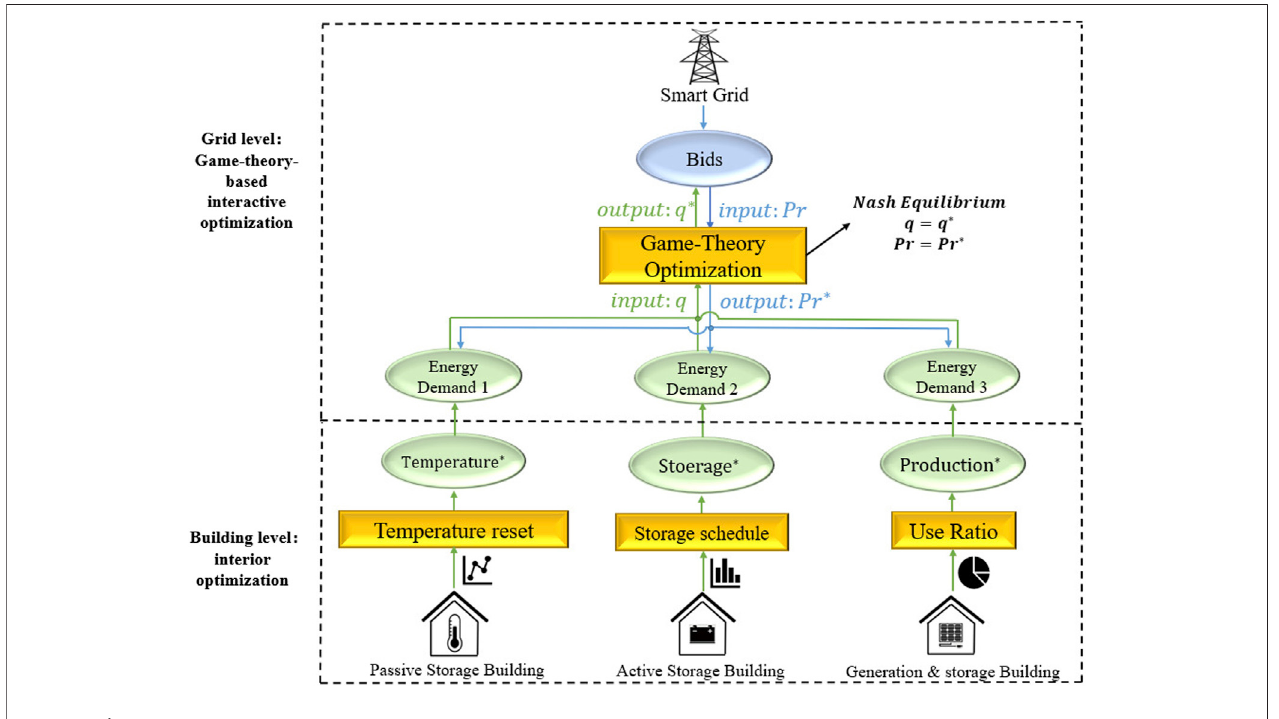
FIGURE 1 | The framework of the proposed hierarchical optimization strategy.